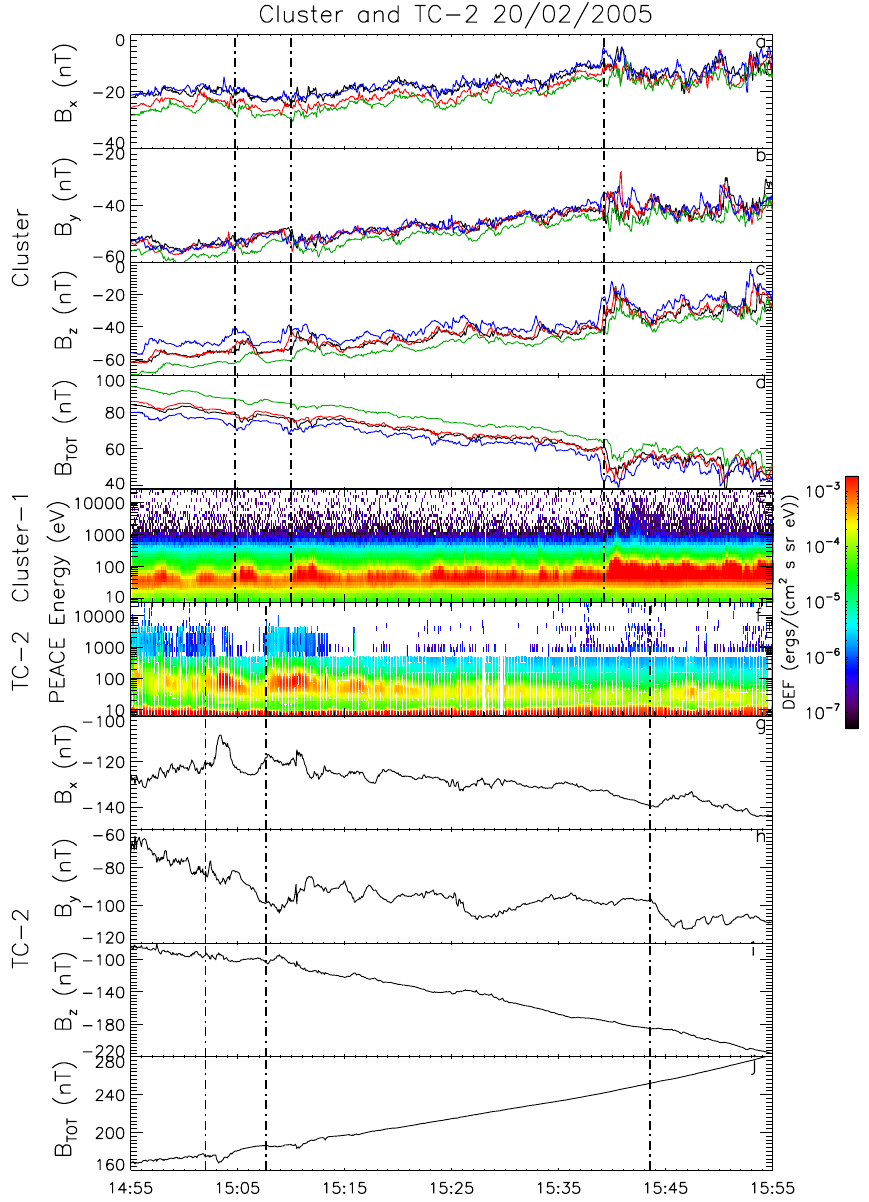
Fig. 2. Overview of the Cluster and TC-2 magnetic field (FGM) and electron fluxes (PEACE) for the 14:55–15:55UT period. (a) to (d) X , Y , Z components and magnitude of the magnetic field at the four Cluster in GSM coordinates (black line for sc-1, red for sc-2, green for sc-3 and blue for sc-4). (e) and (f) Omnidirectionnal electron energy-time spectrograms at Cluster-1 and TC-2. (g) to (j) X , Y , Z components and magnitude of the magnetic field at TC-2 in GSM coordinates. The dash-dotted lines represent the beginning of each